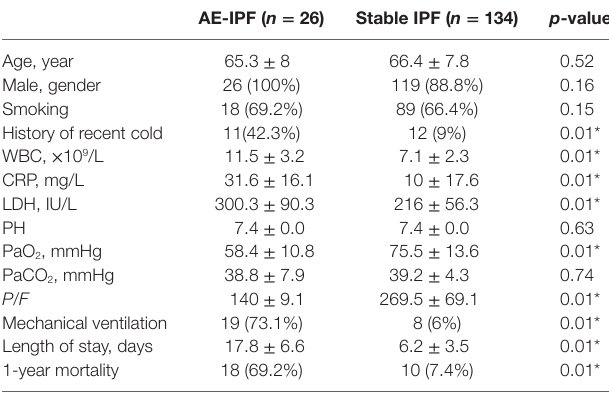
TaBle 1 | Demographic and clinical characteristic of